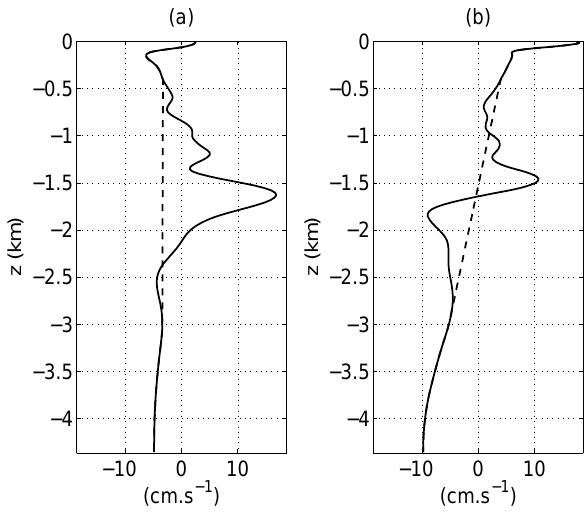
Fig. 8. Real (a) and imaginary (b) parts of the horizontal velocity forcing for E3 (solid line) and E4 (dashed line).